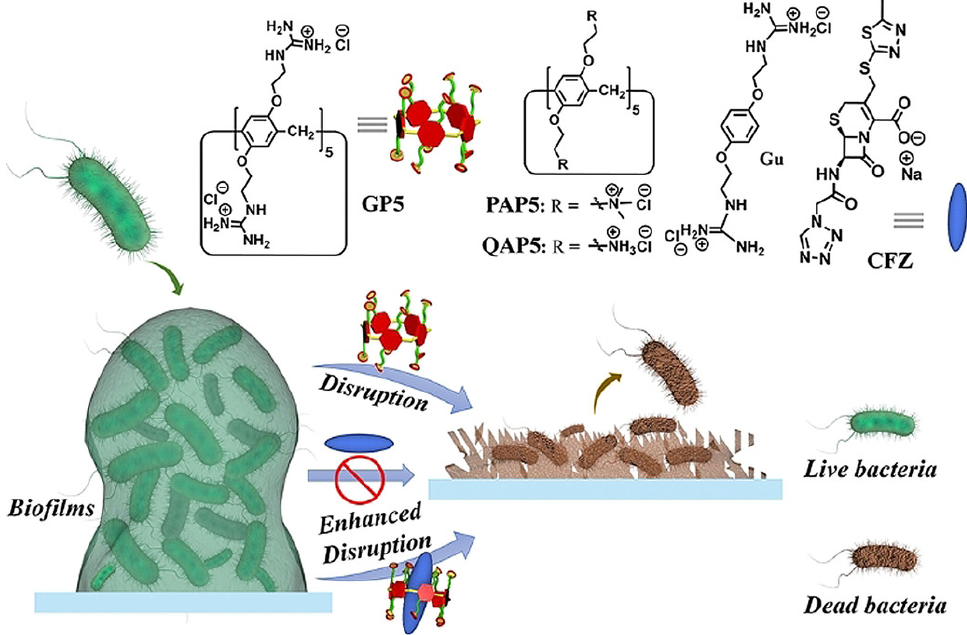
Figure 2. Disruption of biofilms by GP5 and GP5 ⊃ CFZ. Reprinted with permission from Ref. [48]. Copyright 2021 Wiley-VCH.